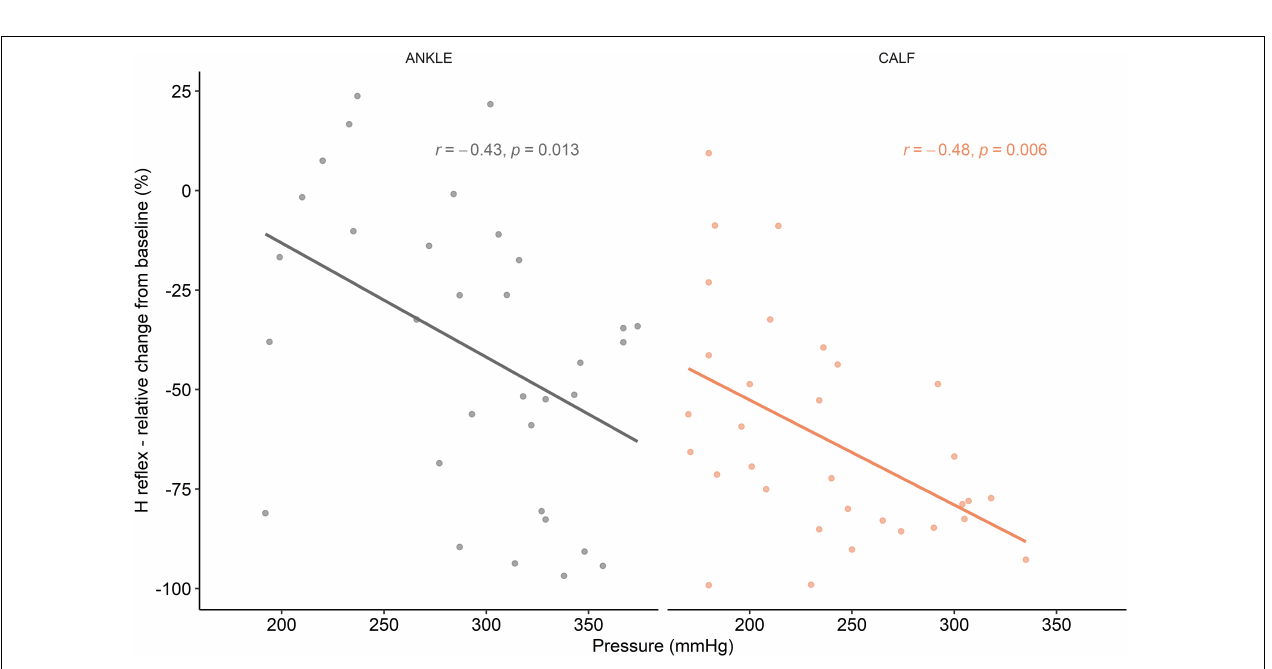
FIGURE 3 | H reflex data expressed as a percentage of Mmax. Orange squares represent data for the CALF condition, gray dots represent data for the ANKLE condition and blue triangles represent data for the CON condition. Larger points and horizontal lines represent the mean and standard error of the average of all H reflex (9 signals) amplitudes in each time point. Small points represent the mean and standard error of each measured H reflex. Statistically significant differences from baseline are represented by asterisks for the CALF condition: ∗∗∗ P < 0.001; and dollars for the ANKLE condition: $$ P < 0.01, $$$ P < 0.001.